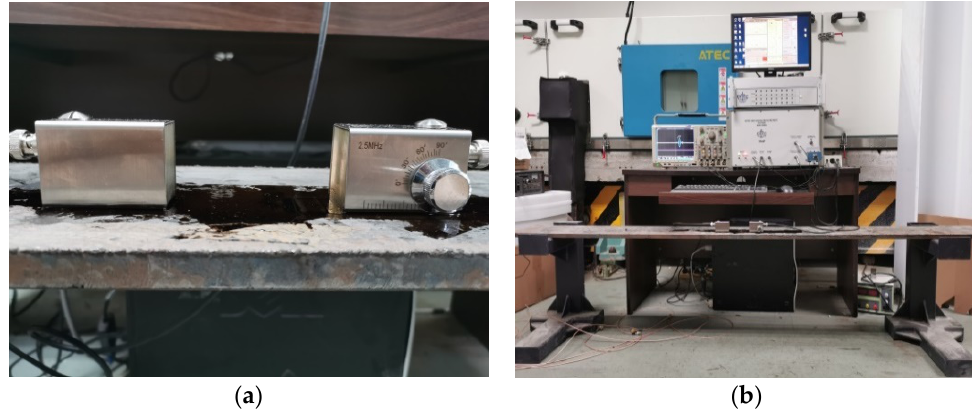
Figure 8. Physical experiment system: ( a ) the excitation and receiving angle probes for Lamb waves in the steel plate; ( b ) high-energy ultrasonic testing system.